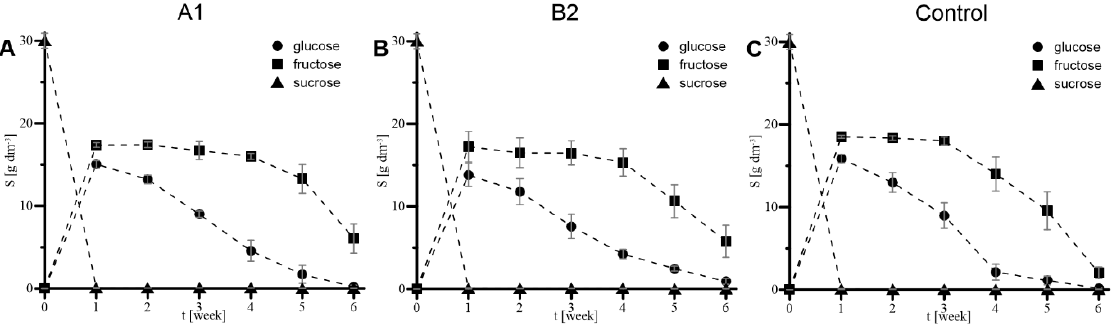
Figure 10. The concentration profiles of sucrose, glucose, and fructose characterizing the prolonged 42-day (i.e., 6-week) cultures supported with xerogels A1 (disintegrated mesoporous xerogel) ( A ) and B2 (PP-reinforced microporous xerogel) ( B ) and the control culture ( C ). Values of µ, Y P/X , and Y X/S obtained for the prolonged 42-day (i.e., 6 weeks) cultures of R. graeca hairy roots supported with xerogels A1 and B2, and the control culture, are presented in Table 2. The highest value of µ gave the culture with xerogel A1. For control culture and culture with xerogel B2, the µ values were equal, but they were almost 20% lower than the µ value characterizing culture supported with xerogel A1. The highest Y P/X